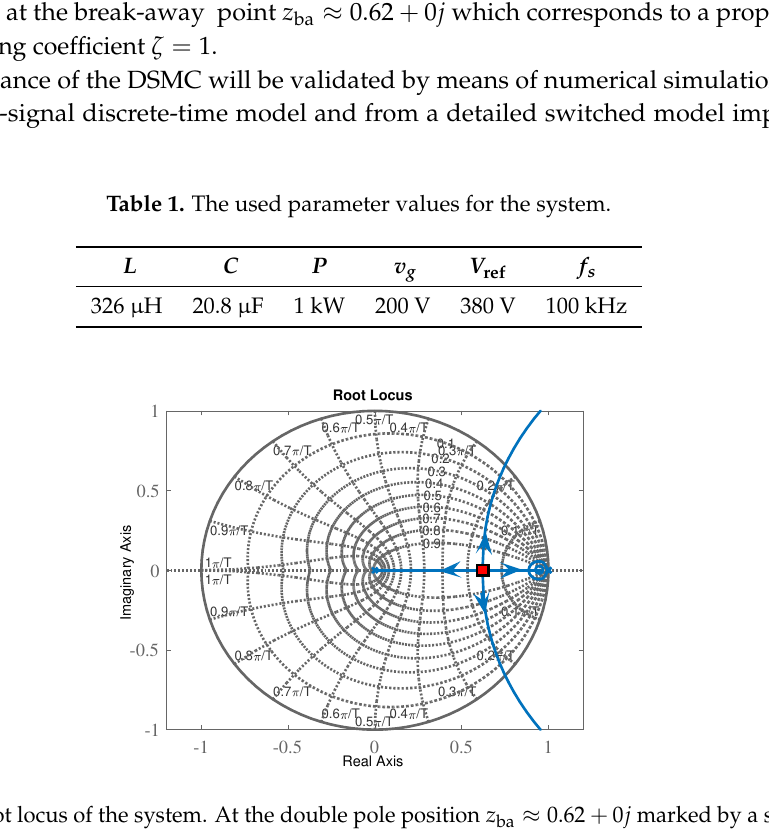
0.62 + 0 j marked by a square on ≈